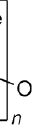
Figure 1. General structure of linear PDMS.